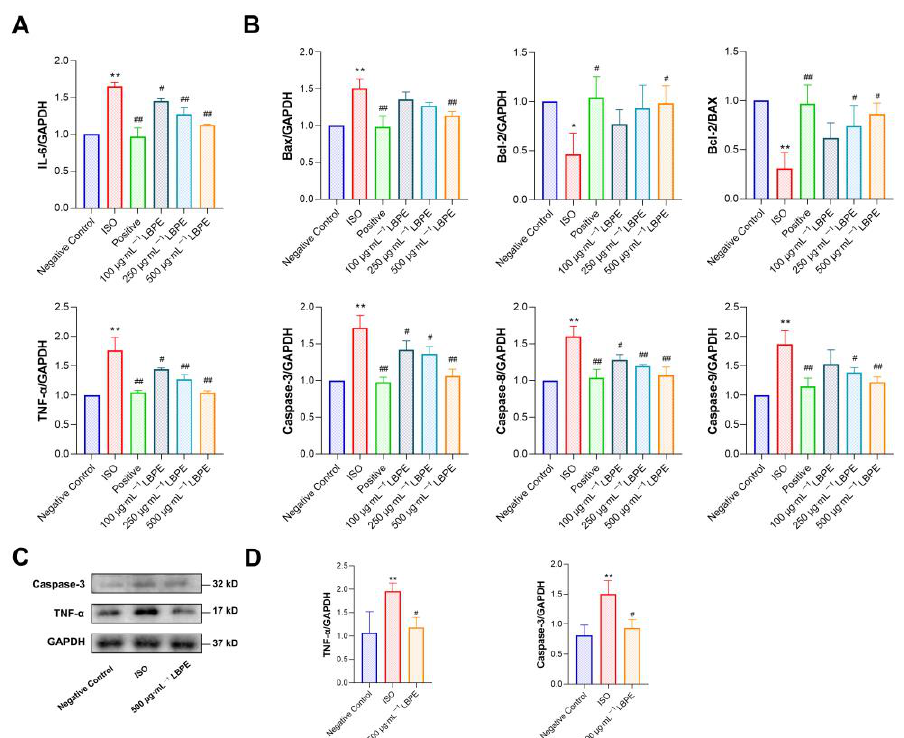
Figure 4. Effects of LBPE on the gene expression of ( A ) pro-inflammatory cytokines and ( B ) apoptosis-related factors, as well as ( C ) the protein expression and ( D ) quantified Western blot results of TNF- α and Caspase-3 in H9c2 cardiomyocytes (n = 3). ISO group vs. negative control group, * p < 0.05, ** p < 0.01. Positive and LBPE groups vs. ISO group, # p < 0.05, ## p < 0.01.